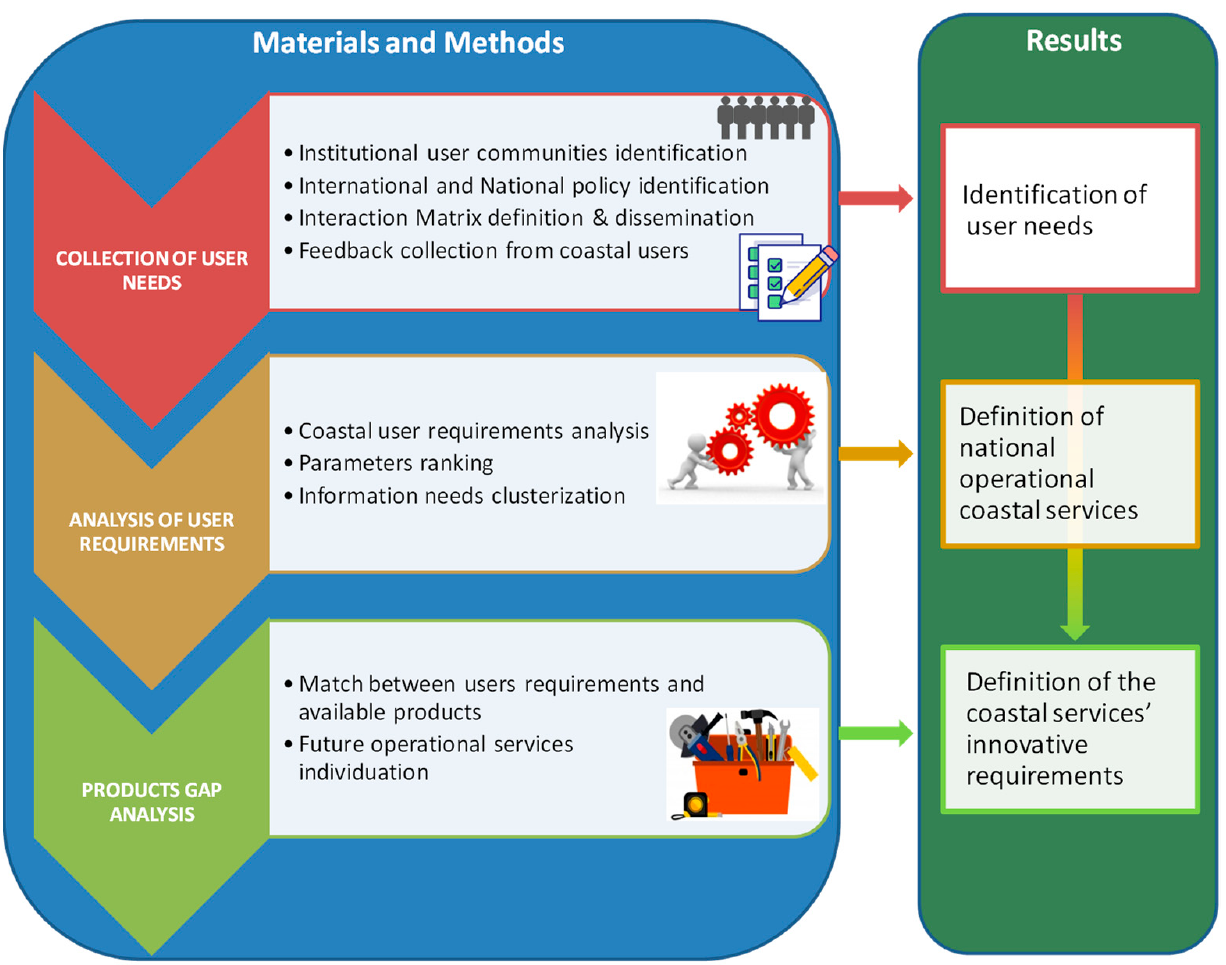
Figure 1. Methodology scheme for user requirements analysis and operational coastal services definition.